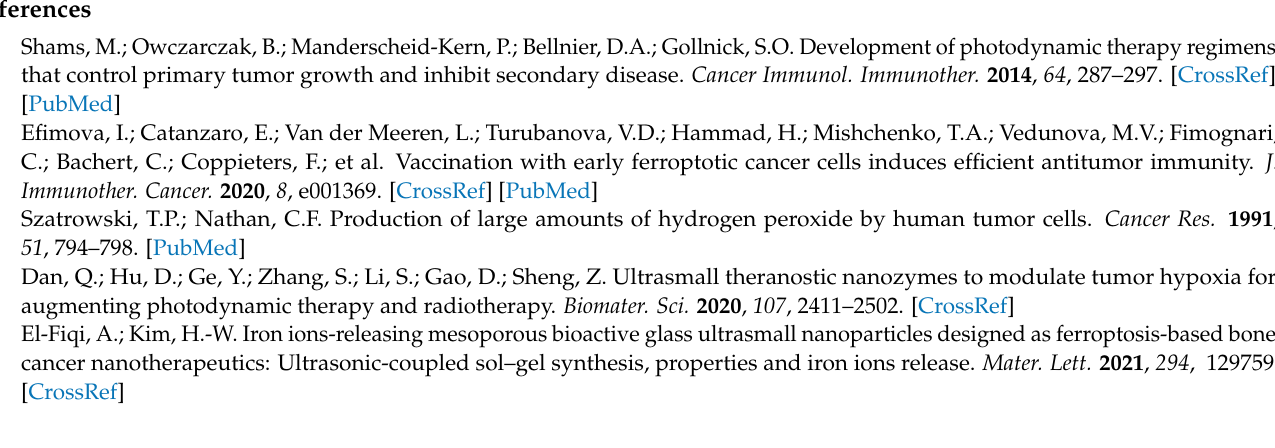
Figure S2: UV-Vis spectra of Fe 2+ and Fe 3+ ion release kinetics (a) Fe 3 O 4 , (b) γ -Fe 2 O 3 , (c) δ